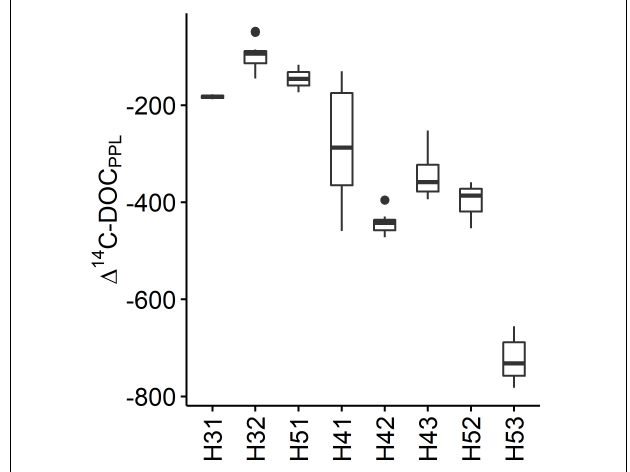
FIGURE 2 | Distribution of (cid:49) 14 C values of SPE-DOM in the Hainich CZE aquifers. Data from 07/2014 to